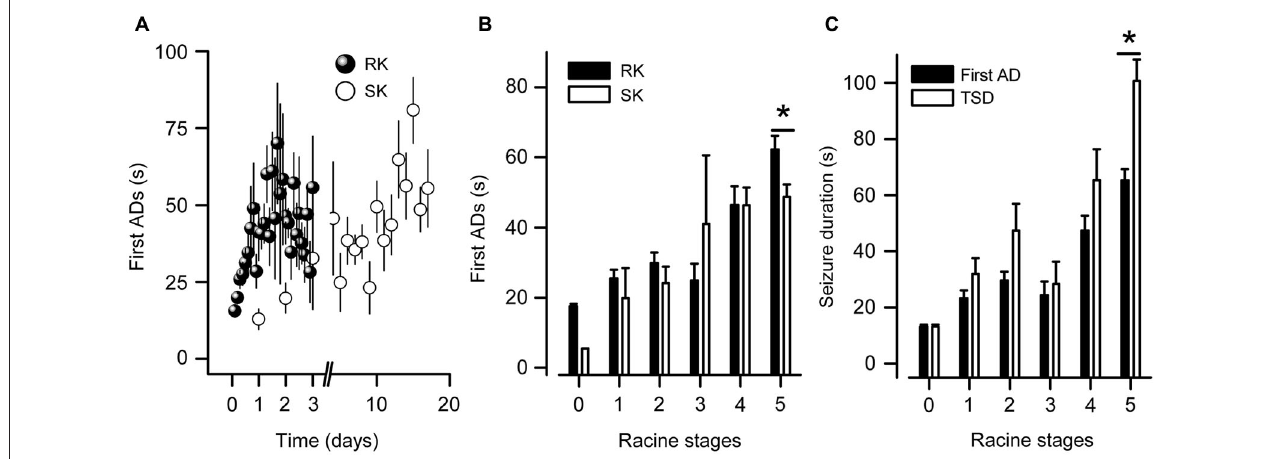
durations corresponding to first AD and first plus secondary ADs (TSD) recorded in M1 cortex induced by RK protocol. Notice that at R5, a variable number of secondary ADs following the first one were observed, in which tonic-clonic convulsions were absent ( t -test, * p < 0.05, n = 9 in RK and n = 5 in